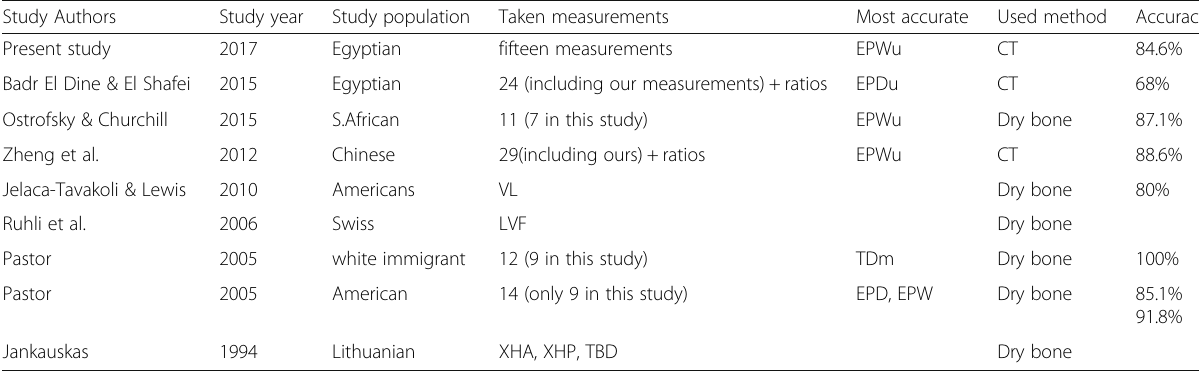
Table 5 Sex determination studies of first lumbar